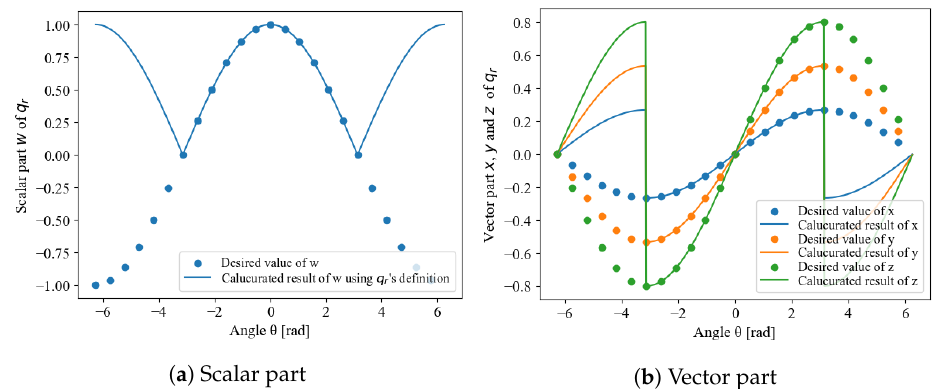
Figure 1. Incontinuity of rotor’s definition.